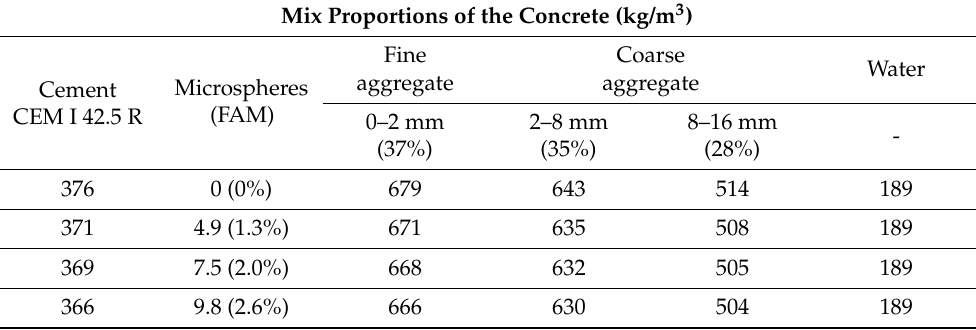
Table 1. Composition of concrete mixtures, w/b = 0.50 1